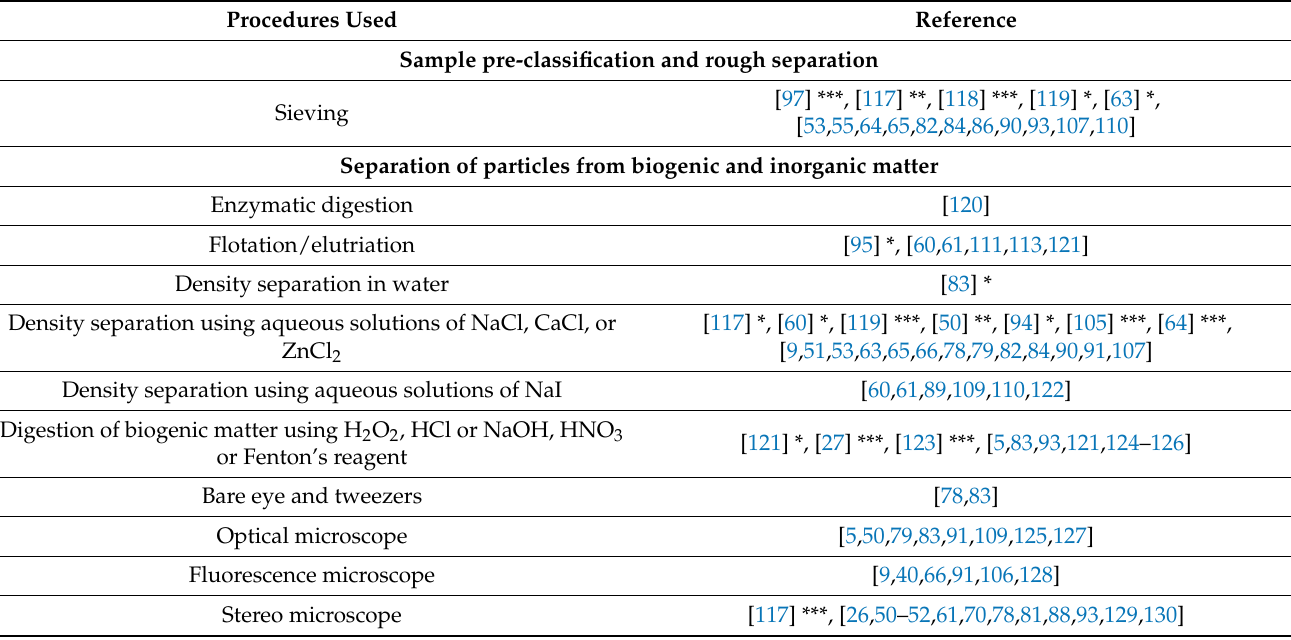
Table 2. Preparation and analysis methods used in selected